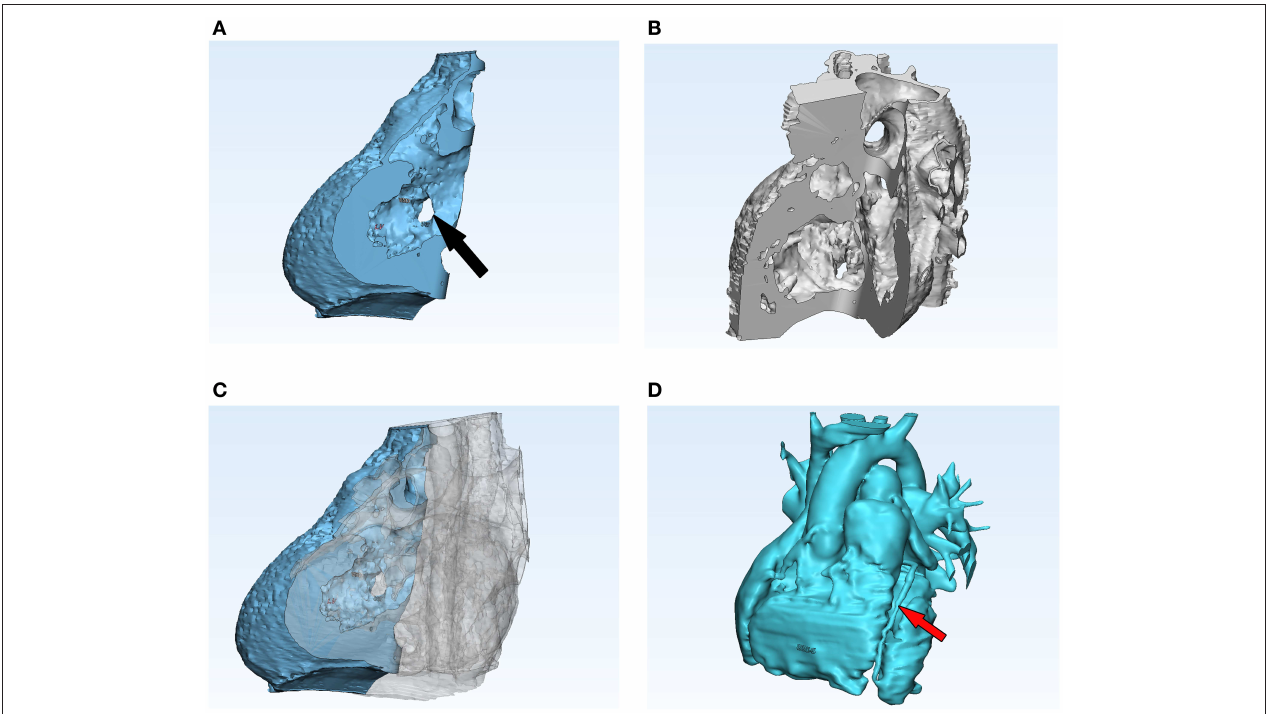
FIGURE 1 | Screenshot of post-processing in 3-Matic. This software was used to cut the myocardium model in such a way that the VSDs could be visualized clearly. The two parts of the model were then printed separately, but fitted together cleanly (A–C) . The blood pool model (D) was also post-processed in 3-Matic and, while cuts were not required for this model, a 2:1 scale model was produced. The black arrow in (A) indicates one of the VSDs and the red arrow in (D) a coronary